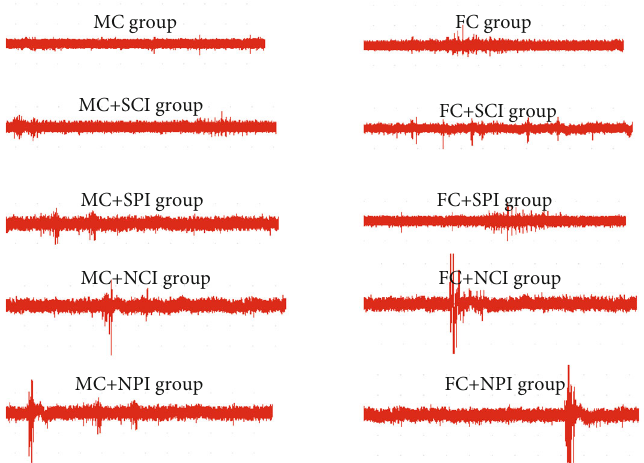
Figure 7: External oblique muscle electrical activity in all groups after NUCB2/NUCB2/Nesfatin-1